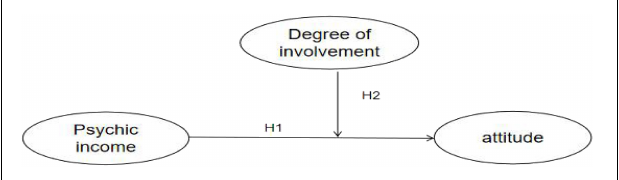
FIGURE 1 | The conceptual model framework of psychic income, involvement, and support